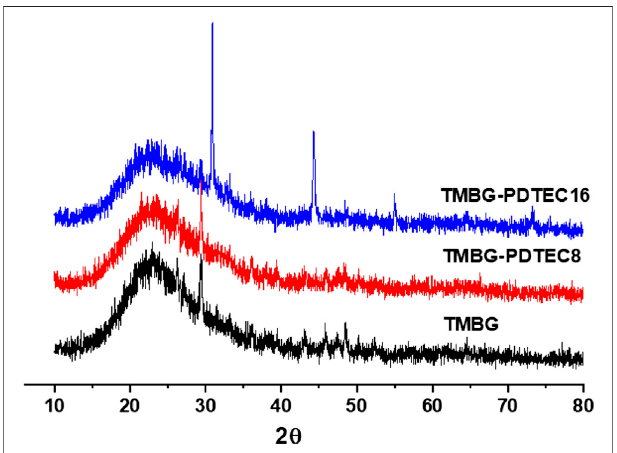
FIGURE 5 | X-ray diffraction (XRD) spectra of the scaffolds (TMBG, TMBG-PDTEC8, and TMBG-PDTEC16) after soaking in SBF buffer solution for 3 ° days at 37 ° C.